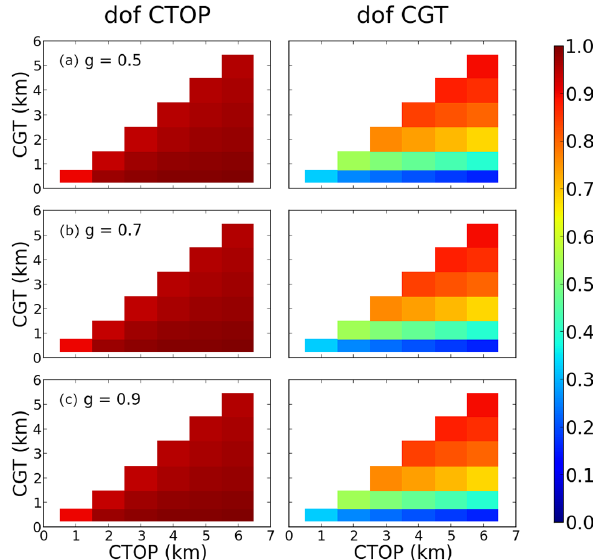
Figure 15. Information content of 3MI A-band with a COT of 16 for different asymmetry factors: (a) g = 0.5, (b) g = 0.7, (c) g = 0.9. Partial DOFs for CTOP (left) and CGT